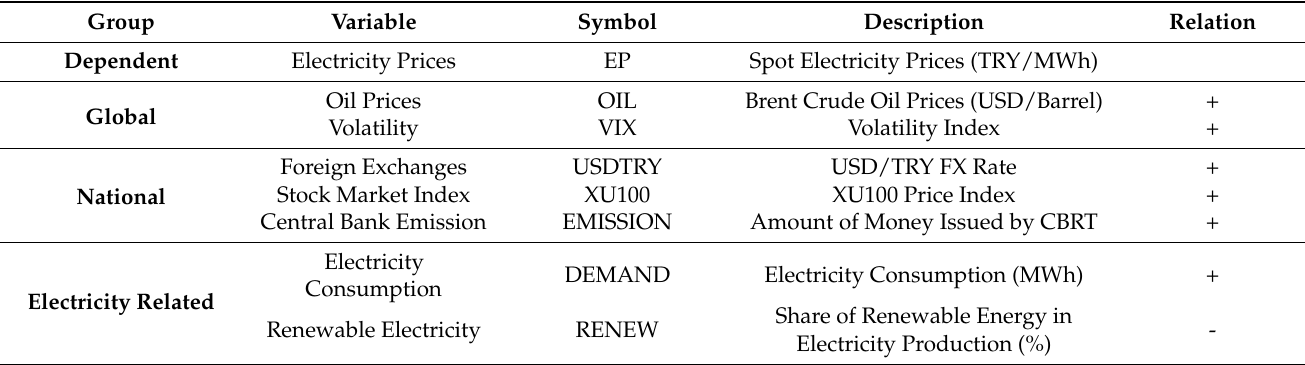
Table 1. The description of the